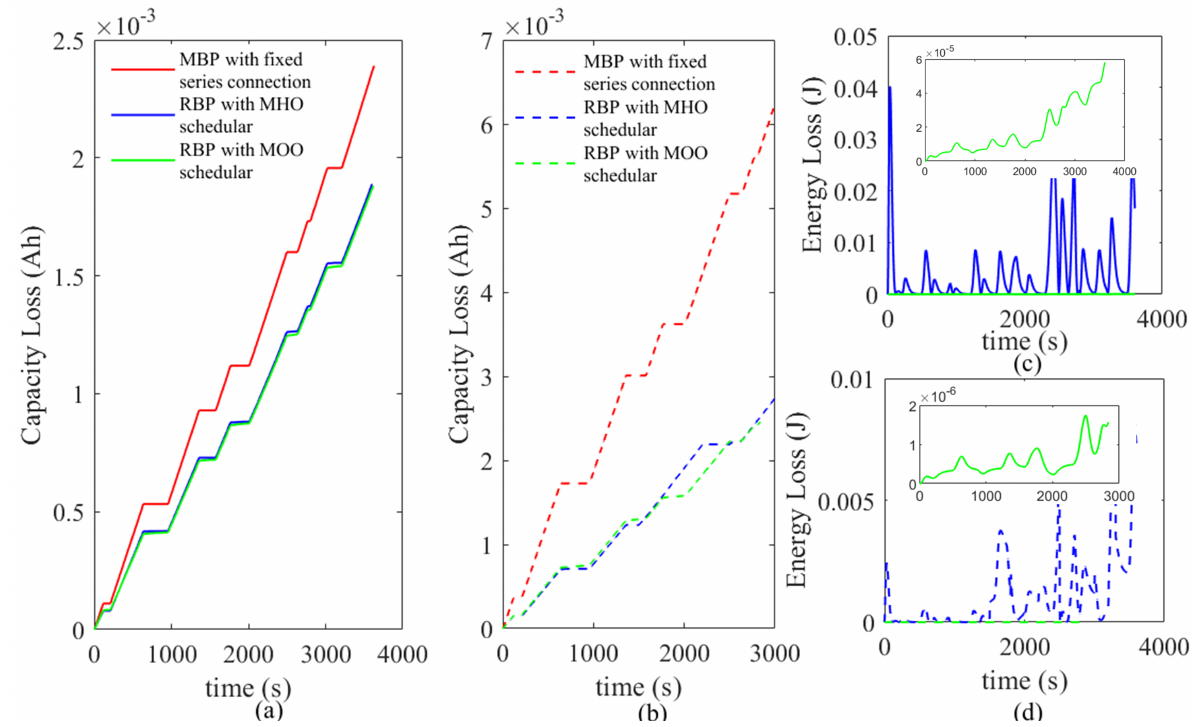
Figure 12. Experimental results of ( a ) the capacity loss with identical cells, Simulation results of ( b ) capacity loss with nonidentical cells, ( c ) energy loss with identical cells, ( d ) and energy loss with nonidentical cells.